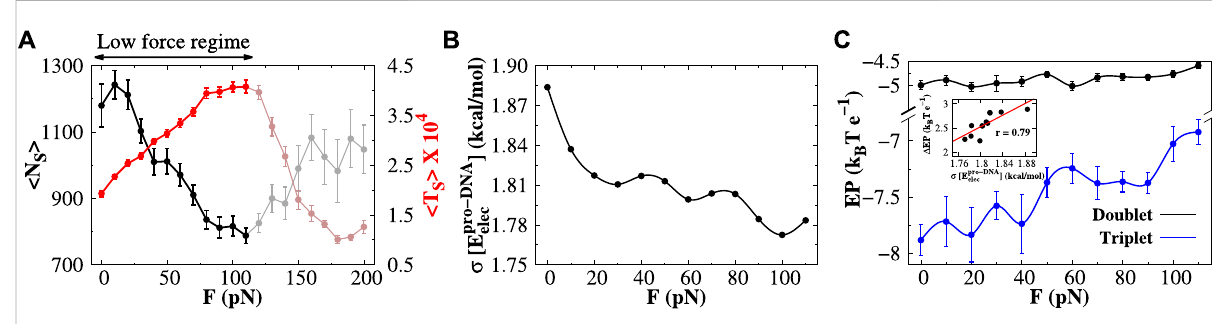
FIGURE 5 Protein diffusion under low stretching force. (A) Variations in the average number of sliding events ( < N S > ; black line) and the average time duration( < T S > ;redline)ofaslidingeventareplottedasafunctionofstretchingforce.Onlytheregimeunderlowstretchingforceishighlighted. (B) Fluctuation (standard deviation) in the protein – DNA electrostatic energy is shown with respect to stretching force. (C) Electrostatic potential of the DNAmoleculeiscalculatedatthereferencepointsinthemajorgrooveasafunctionof F fordoublets(blackline)andtriplets(blueline)usingthe Delphi program (Li et al., 2012). The correlation between the difference in the electrostatic potential for doublets and triplets and the fl uctuation in the protein – DNA electrostatic energy is shown in the inset. The red line represents the best fi ts. The error bar for each symbol is de fi ned as the standard error. In (B) , the associated error bars are smaller than the point size.